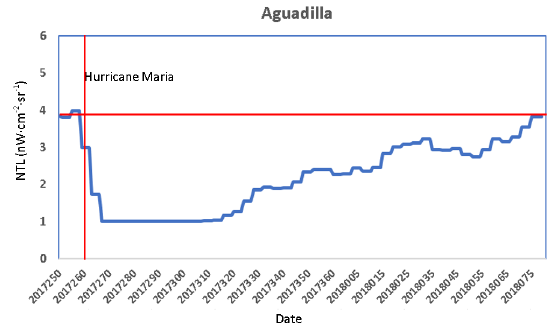
Figure 4. The post-hurricane NTL recovery at Aguadilla, Puerto